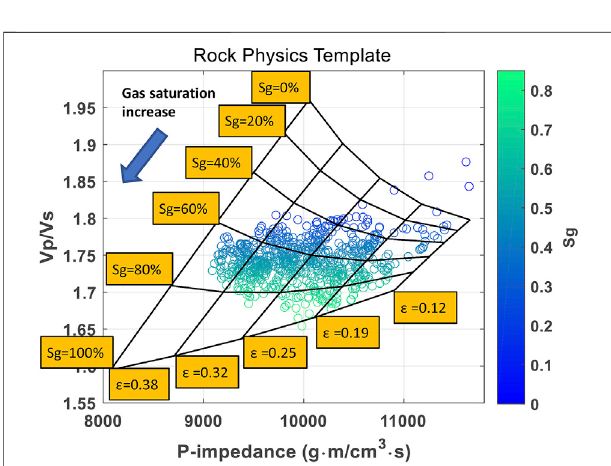
FIGURE 7 | Rock physics template analysis for the interpretation of crack density and gas saturation from cross-plot between the V p / V s and P-impedance. The data points are from Well-1 and color-coded by crack density log. The arrow shows the direction of increasing crack density.